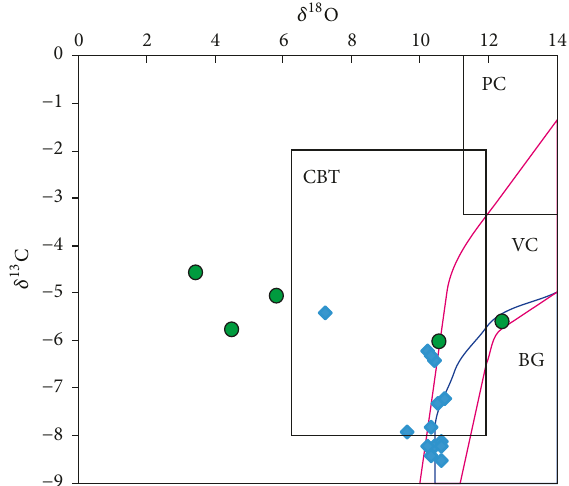
Figure 7: 𝛿 18 O versus 𝛿 13 C plot: circles indicate data from SMOW PDB this study (Table 3) and diamonds indicate data from dolomite marble deposits/veins and a calcite + albite + quartz dike in the Kragerø area by Dahlgren et al. [32]. BG = Bamble hyperites [37]; CBT = world carbonatites [38]; PC = nonmetamorphic proterozoic carbonates [39]; VC = vein carbonate